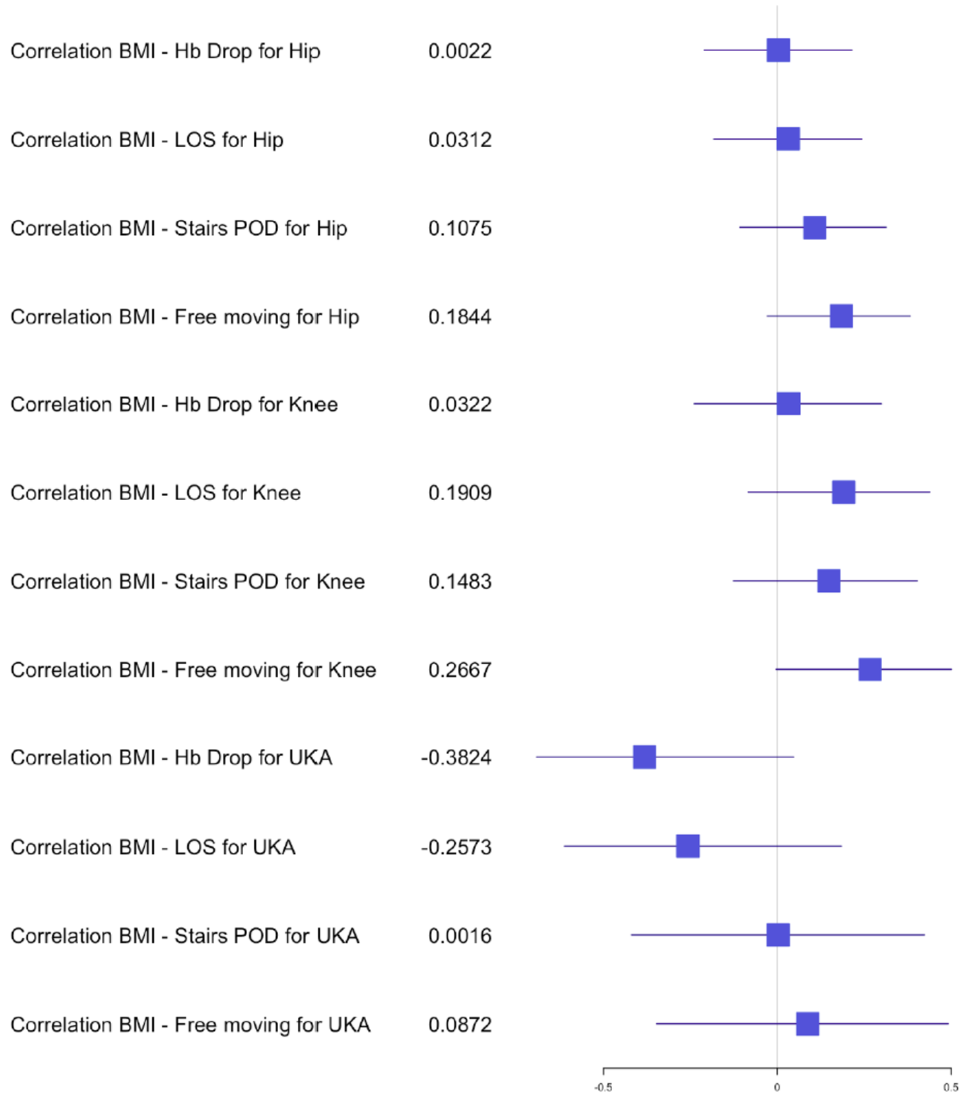
Figure 3. Forest plot for the effects of BMI on Hb drop, LOS and functional outcome for simultaneous arthroplasty.